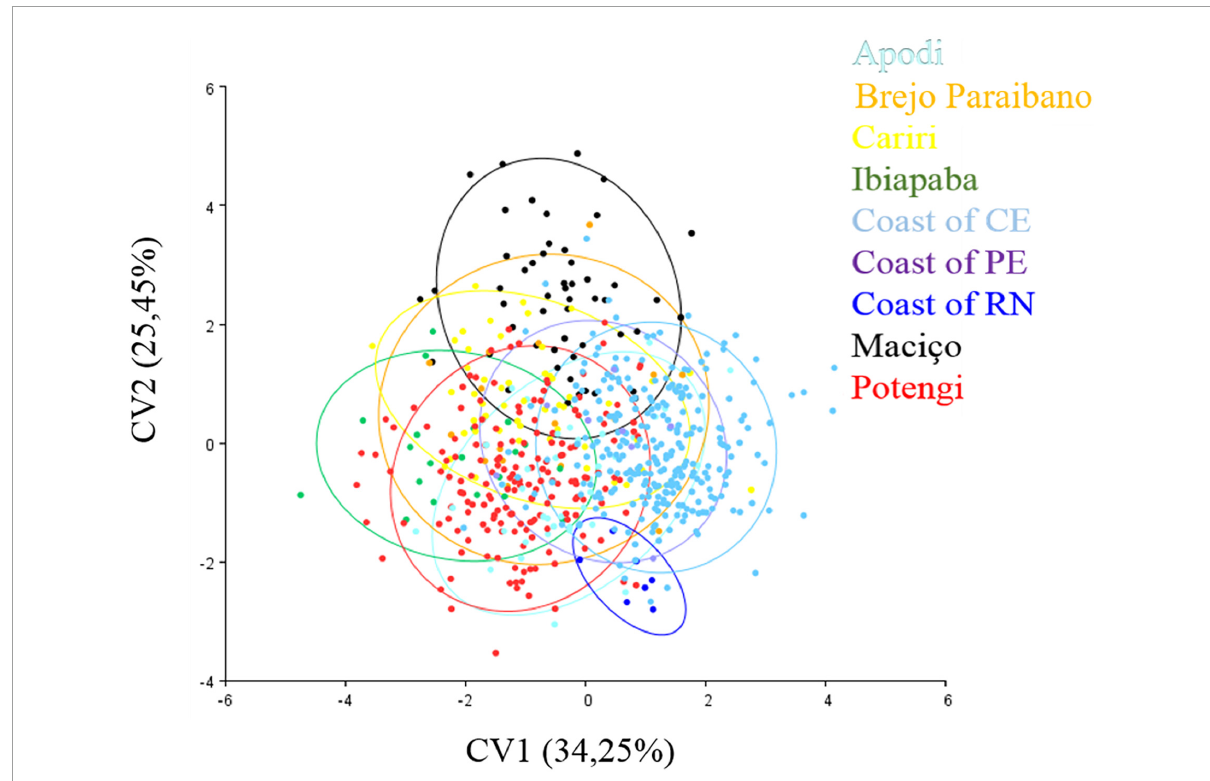
FIGURE4 Canonical variate analysis of the 13 anatomical landmarks marked at the wing rib junctions of Plebeia flavocincta .